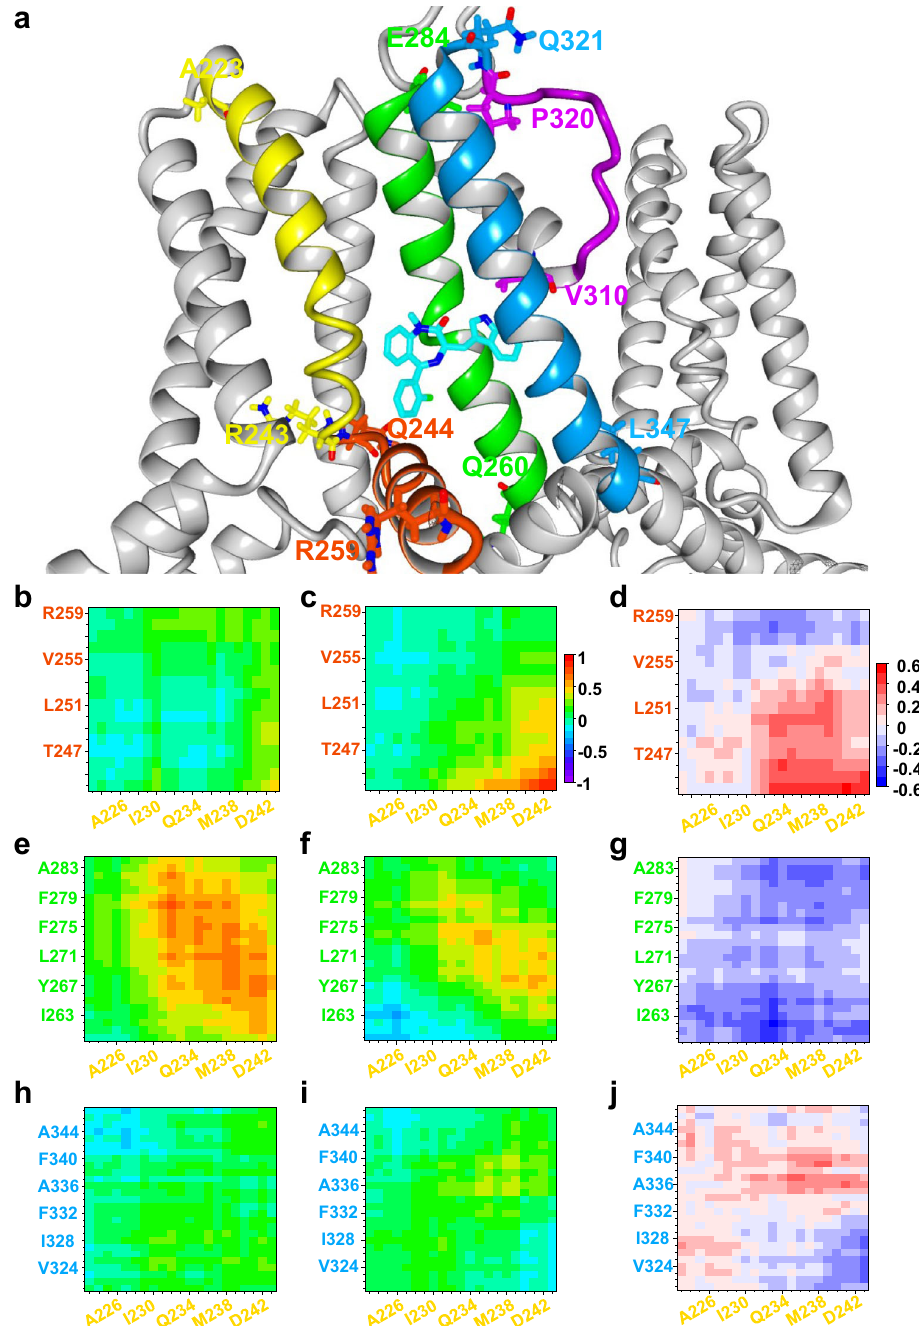
Fig. 7 Dynamic cross-correlation matrices (DCCMs) for interactions between VSD (S4, S4S5 linker) and PD (S5, S6). a ( R )-L3 (CPK-color code with cyan for carbon) binding site between subunit Mol A and B with interacting secondary structures S4 (Mol B, yellow), S4S5 linker (Mol B, orange), S5 (Mol A, green), S6 (Mol A, blue) and selectivity fi lter (Mol A, purple). First and last amino acid of all secondary structures are shown in the same color. b , c Dynamic cross-correlation matrix (DCCM) for S4 (Mol B, yellow) and S4S5 linker (Mol B, orange) in the absence ( b ) and presence ( c ) of ( R )-L3 from − 1 (fully anticorrelated) over 0 (not correlated) to 1 (fully correlated). d Increase (positive values, red) and decrease (negative values, blue) of correlation between S4 and S4S5 linker residues depending on the presence of ( R )-L3. e , f DCCM for S4 (Mol B, yellow) and S5 (Mol A, green) in the absence ( e )/ presence ( f ) of ( R )-L3. g Increase (positive values, red) and decrease (negative values, blue) of correlation between S4 and S5 residues depending on the presence of ( R )-L3. h , i DCCM for S4 (Mol B, yellow) and S6 (Mol A, blue) in the absence ( h )/presence ( i ) of ( R )-L3. j Increase (positive values, red) and decrease (negative values, blue) of correlation between S4 and S6 residues depending on the presence of ( R )-L3. All data of Fig. 7 are derived from 5 independent simulations in the presence and 3 independent simulations in the absence of ( R